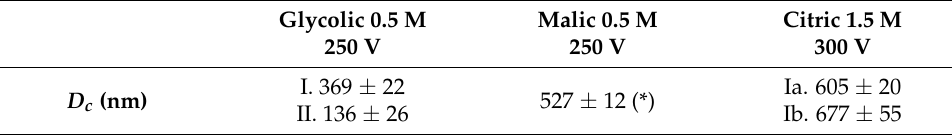
Figure 7. SEM images of the Al substrates after the dissolution of the oxide obtained during anodization in 0.5 M citric acid solution at 300 V and 0 and 5 °C (SEM images in the ( right ) column are larger magnifications of the respective images in the ( left ) column). Table 3. Interpore distance ( D c ) in AAO produced in various AHAs electrolytes at 5 ◦